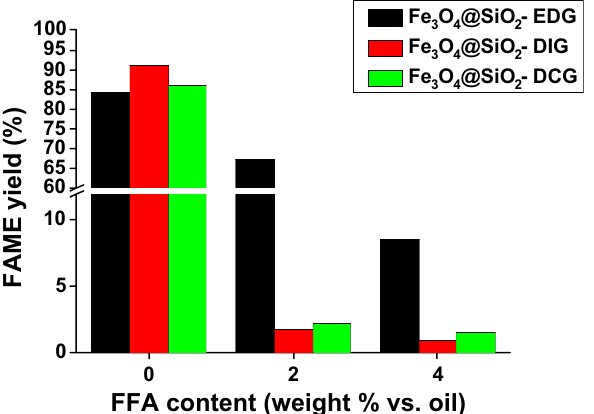
Figure 9. FAME yield depending on the FFA (wt% vs. oil) content and catalyst type (activated catalyst; temperature 80 °C (MW irradiation); reaction time 180 min; molar ratio oil/MeOH 1/6; 3.5% weight ratio catalyst vs. oil; 780 rpm).